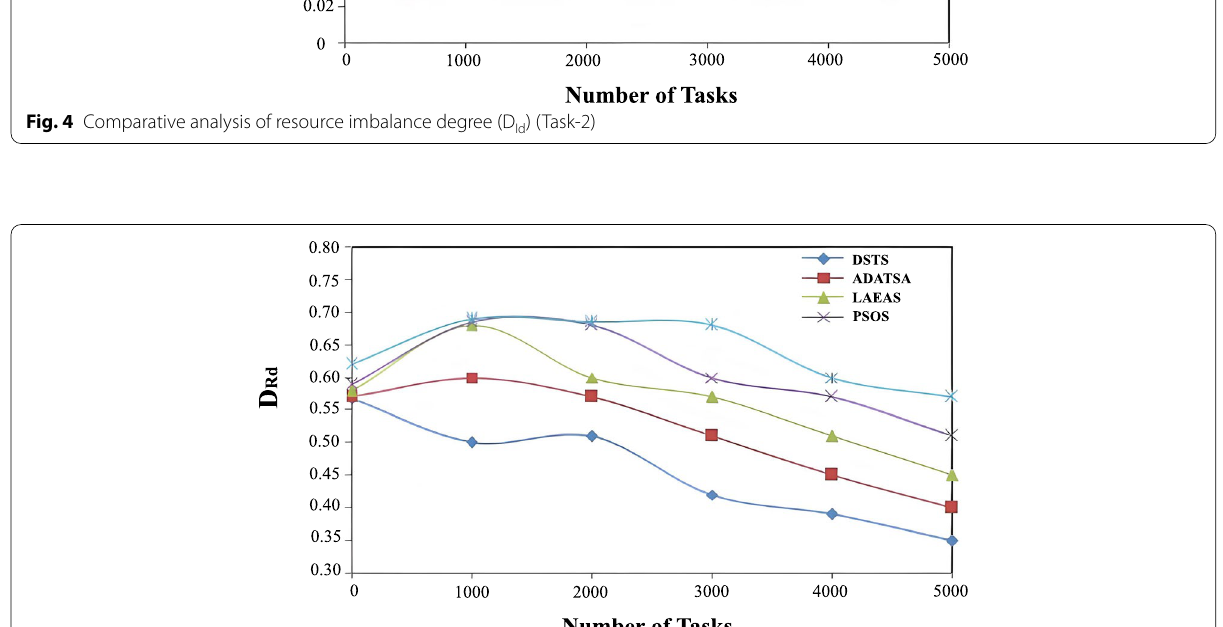
Fig. 5 Comparative analysis of resource residual degree (D Rd )